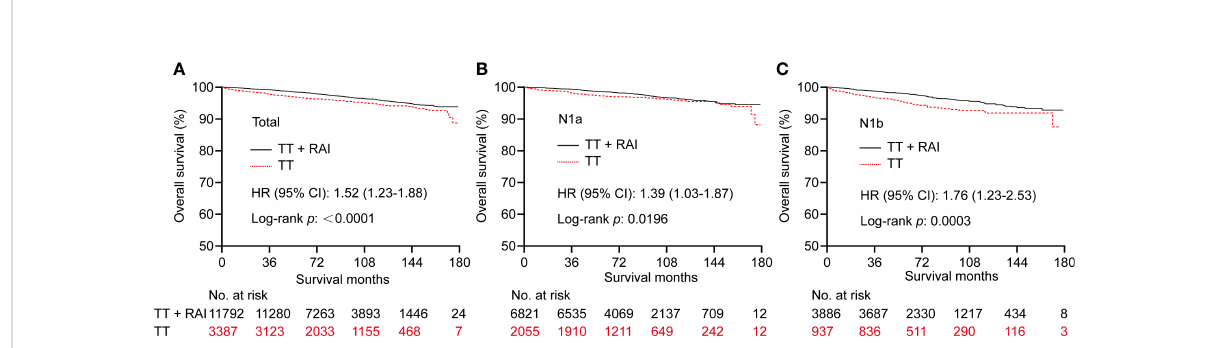
FIGURE 2 Kaplan – Meier curves of OS in PTC patients who underwent TT vs. TT+RAI before PSM in total patients (A) , N1a patients (B) , and N1b patients (C) . OS, overall survival; PTC, papillary thyroid carcinoma; TT, total thyroidectomy; RAI, radioactive iodine; PSM, propensity score